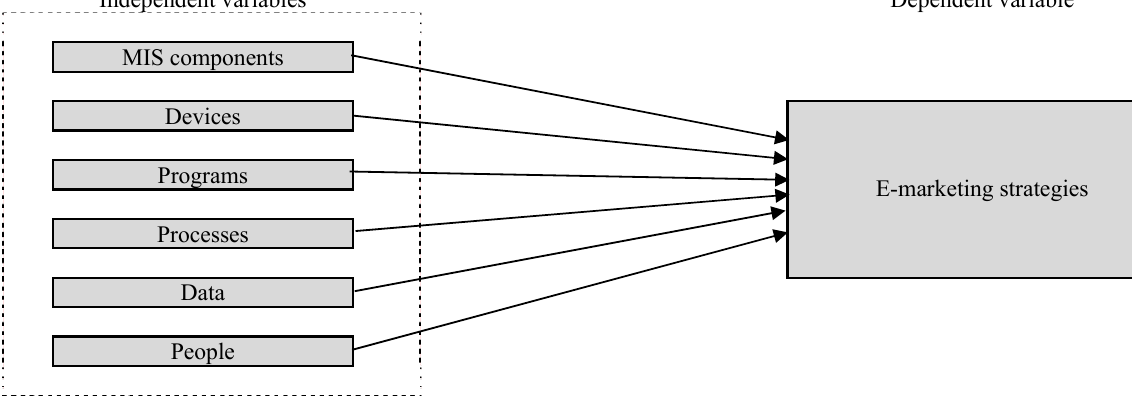
Fig. 1. The structure of the proposed